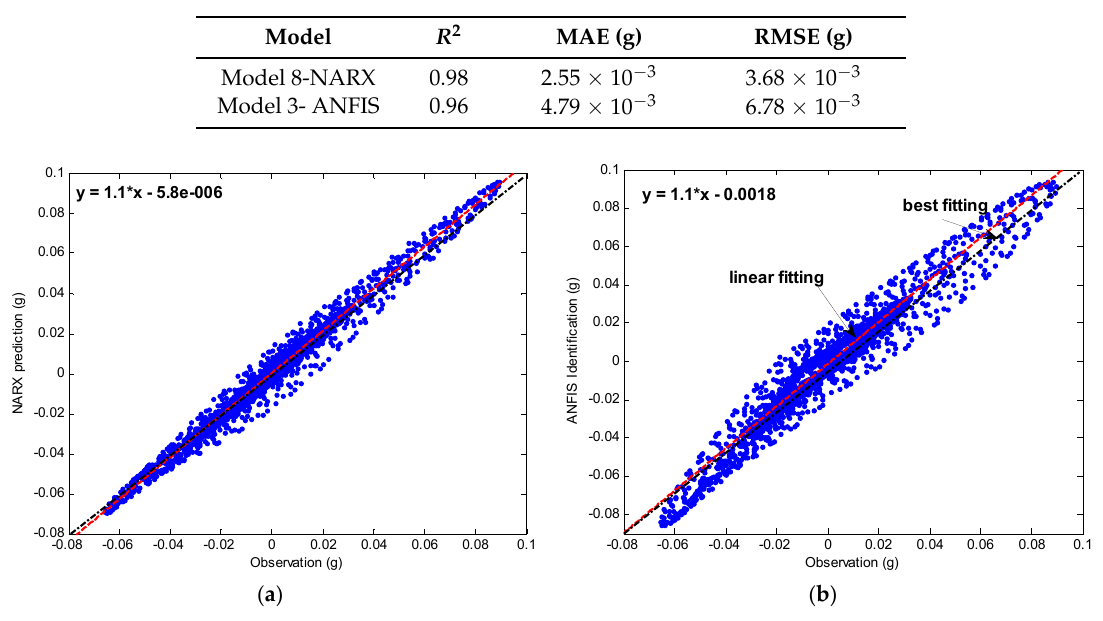
Table 5. Testing models performance evaluation.